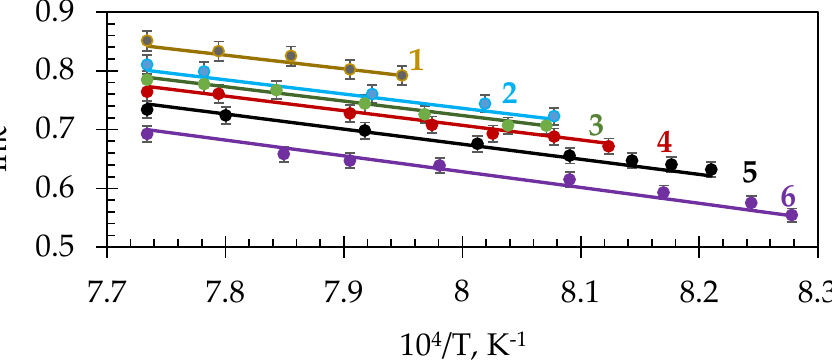
Figure 5. Electrical conductivity of cryolite melts: points denote experimental results, lines denote calculation results (Equation (8)) (wt%): 1—NaF-AlF 3 CR = 2.5, C (Al 2 O 3 ) = 2, C (CaF 2 ) = 5; 2—CR = 2.3, C (Al 2 O 3 ) = 2, C (CaF 2 ) = 5; 3—CR = 2.5, C (Al 2 O 3 ) = 6, C (CaF 2 ) = 5; 4—CR = 2.3, C (Al 2 O 3 ) = 4, C (CaF 2 ) = 5; 5—CR = 2.1, C (Al 2 O 3 ) = 3, C (CaF 2 ) = 5; 6—CR = 2.1, C (Al 2 O 3 ) = 6, C (CaF 2 ) =